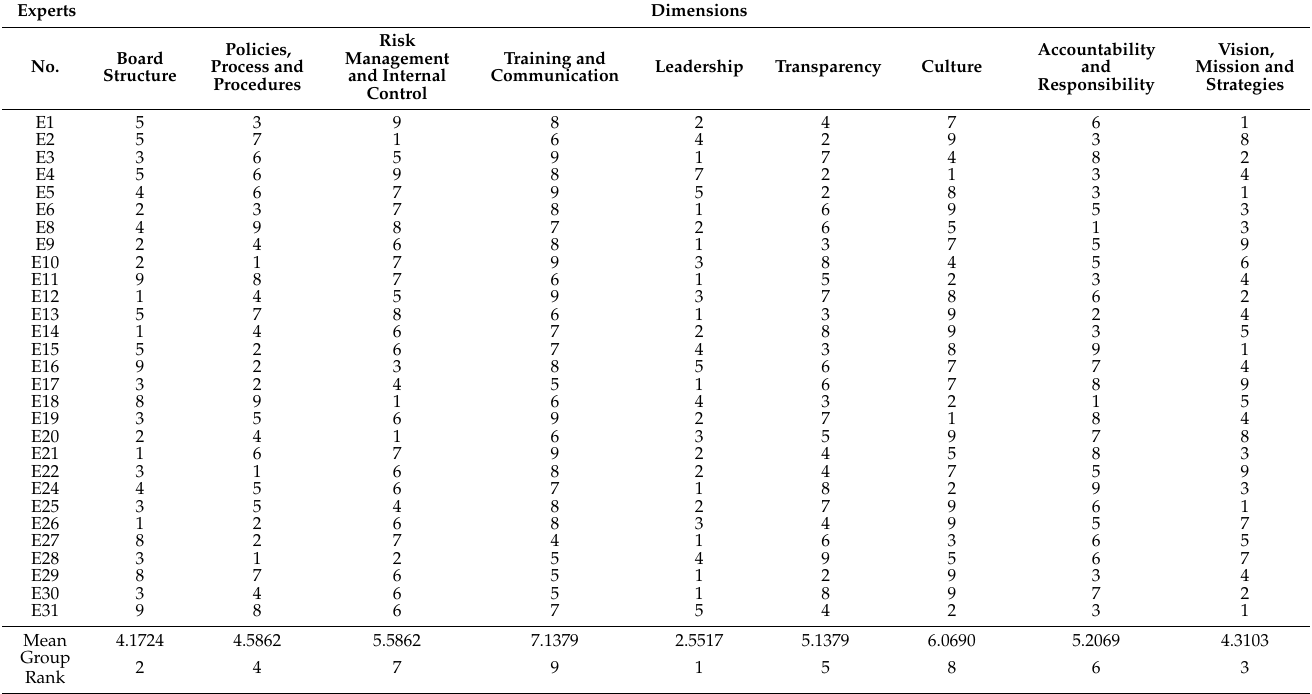
Table 3. Second Round of the Delphi